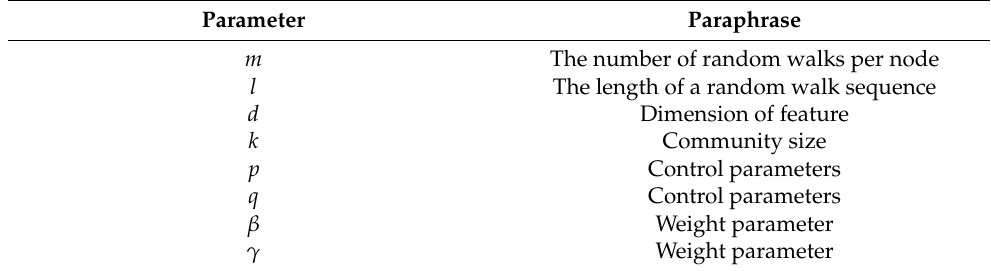
Table 1. Description of parameters in the network presentation learning